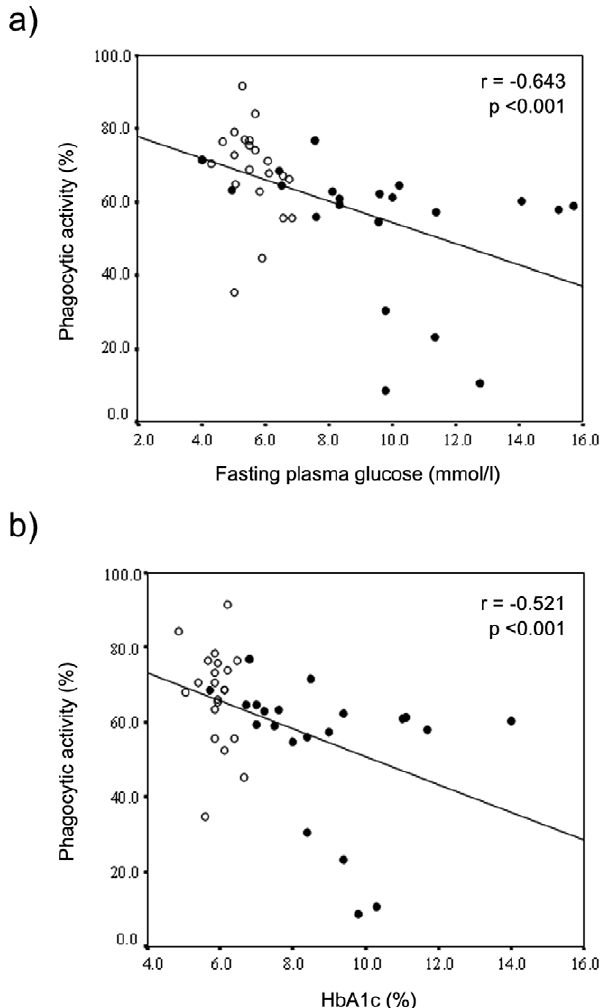
Figure 1. Correlations of fasting plasma glucose (a) and HbA1c (b) with phagocytic activity in the whole population. White circles, non-diabetic patients (fasting glucose: r= 2 0.419, p=0.058; HbA1c: r= 2 0.011, p=0.956); black circles, type 2 diabetic patients (fasting glucose: r= 2 0.601, p=0.004; HbA1c: r= 2 0.506, p=0.019).